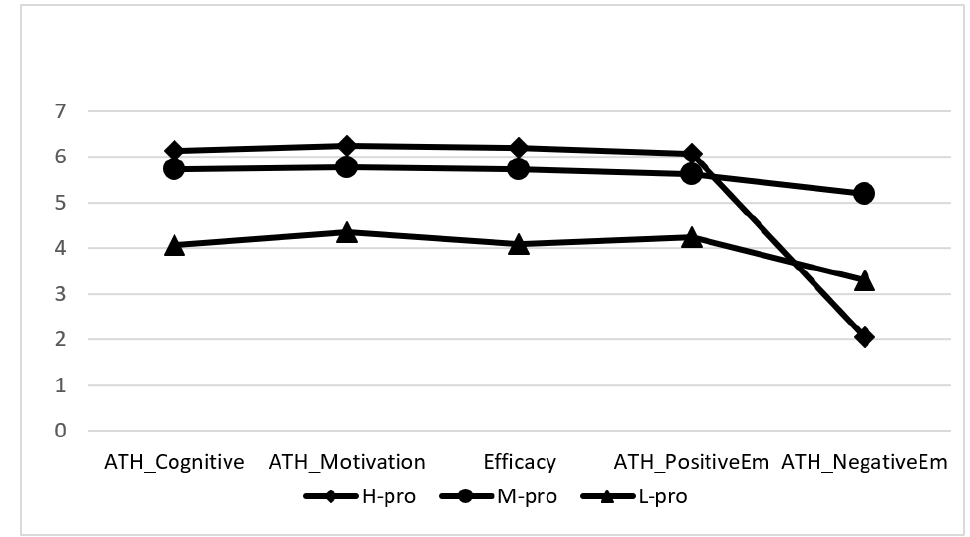
Figure 1. Profiles of health proactivity ( n = 3391).